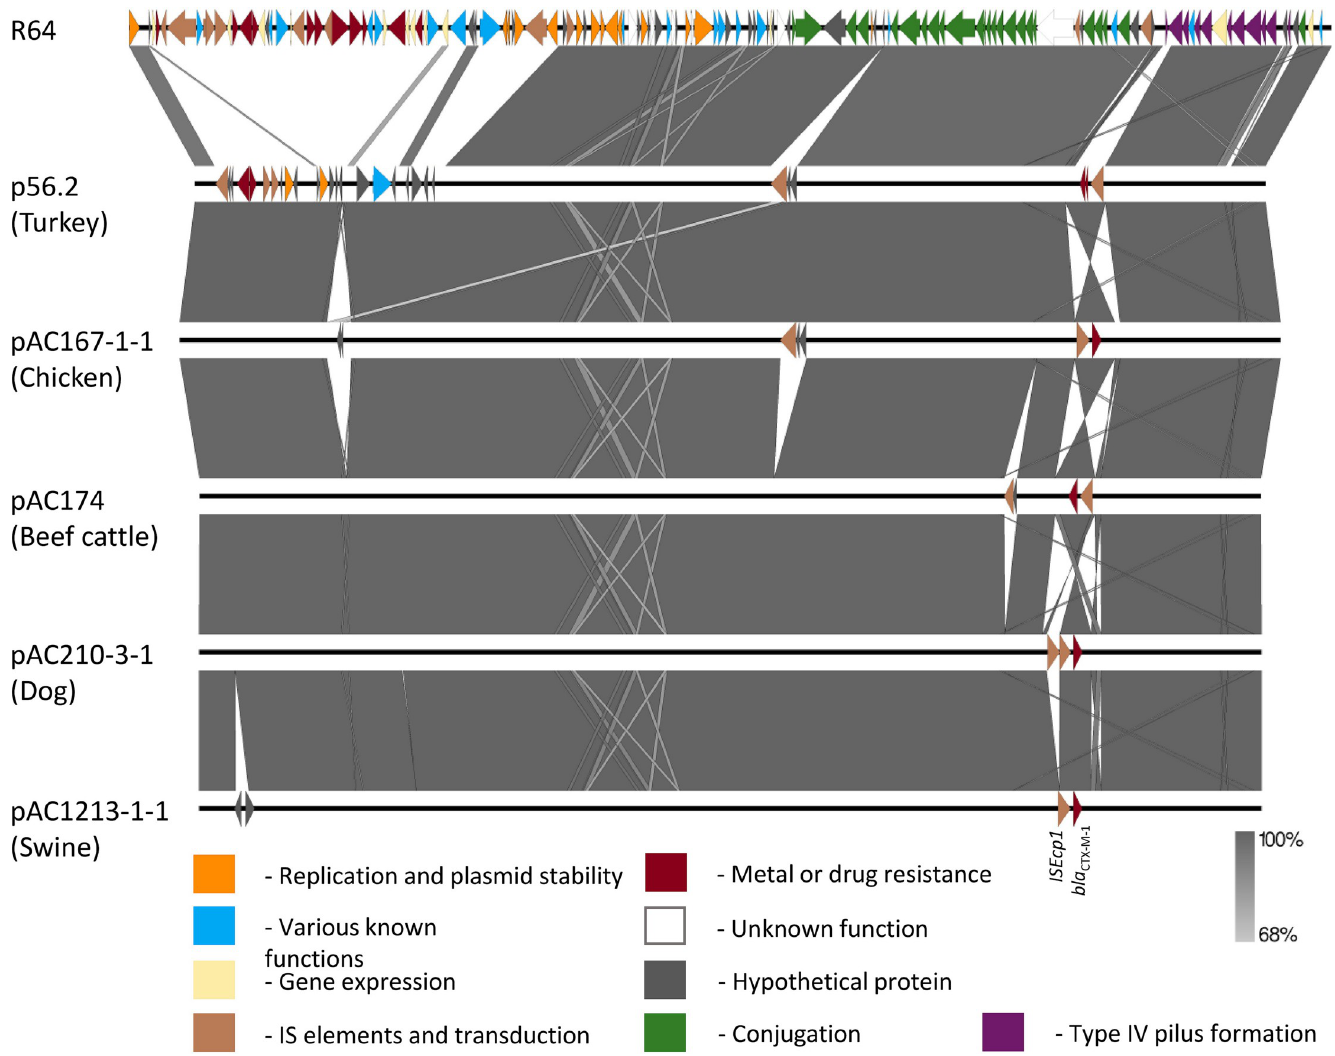
Fig 1. Easyfig alignment of representative IncI1/ST3 plasmids from chicken, turkey, swine, dogs and beef cattle, and R64.